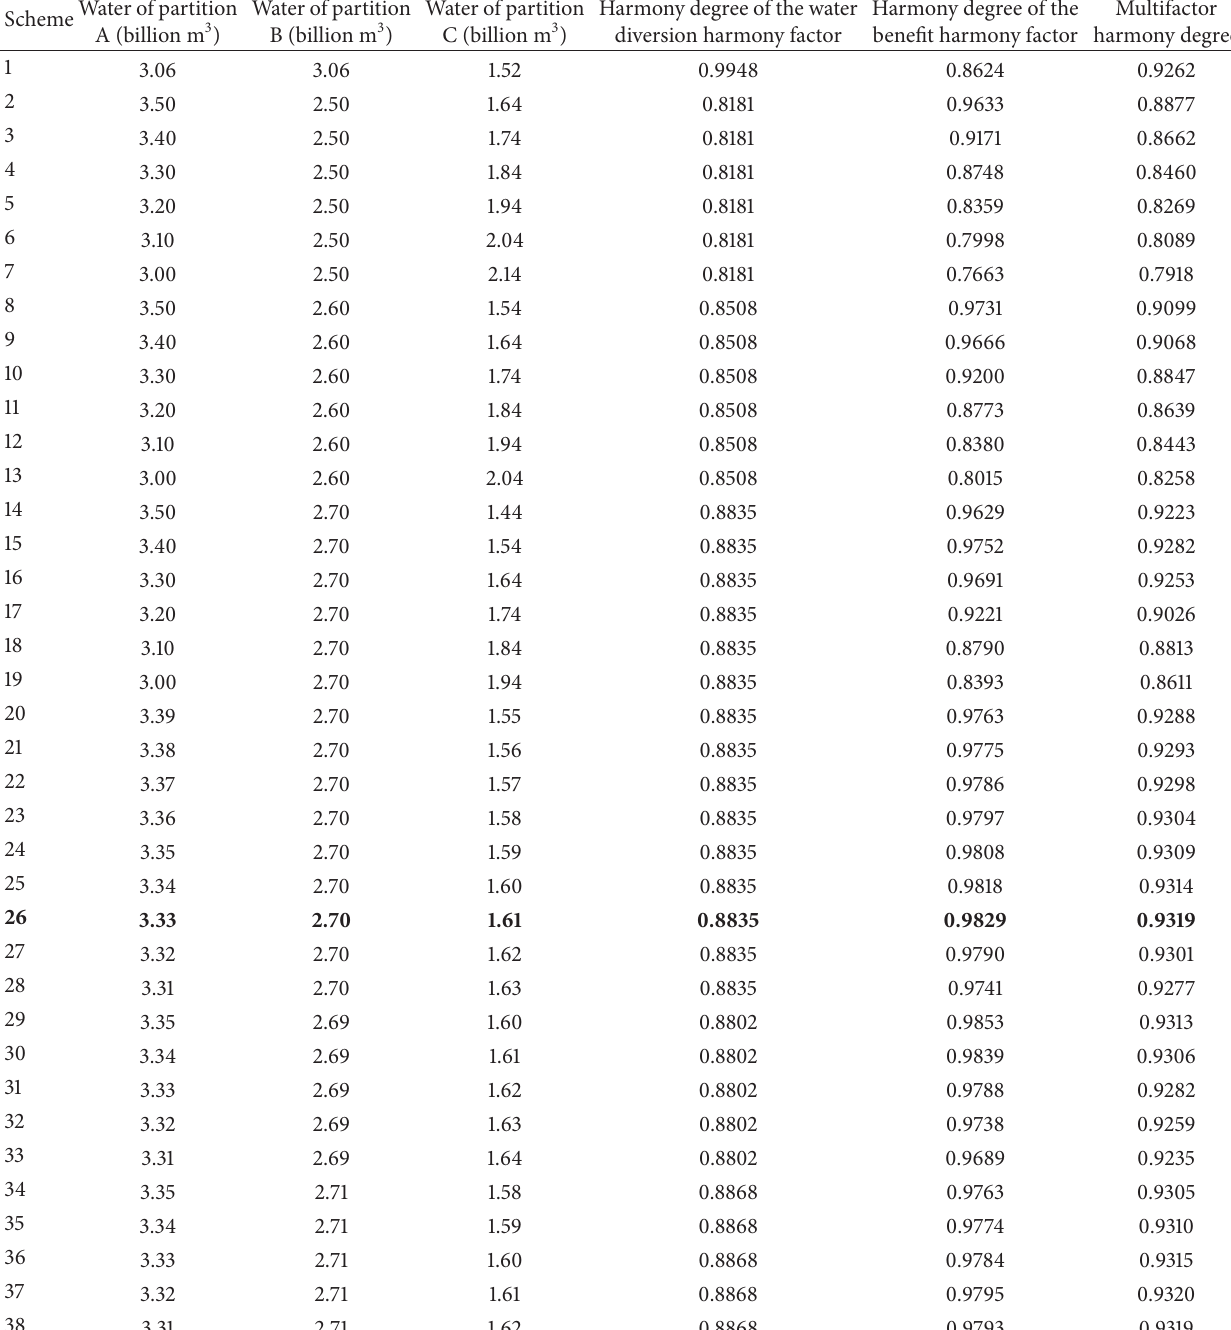
Table 2: Harmony degree calculation for different schemes of water